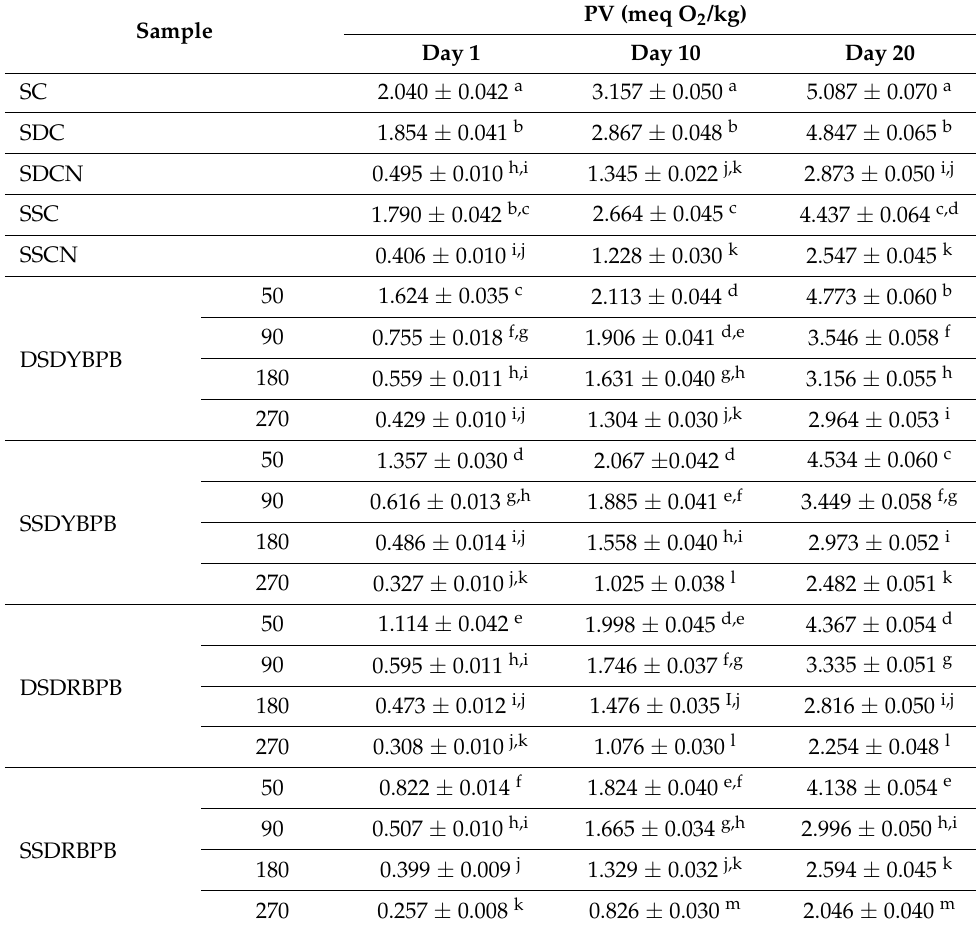
Table 4. The effect of supplementing sausage formulas with bell pepper processing by-products on peroxide value (PV) during 20 days of